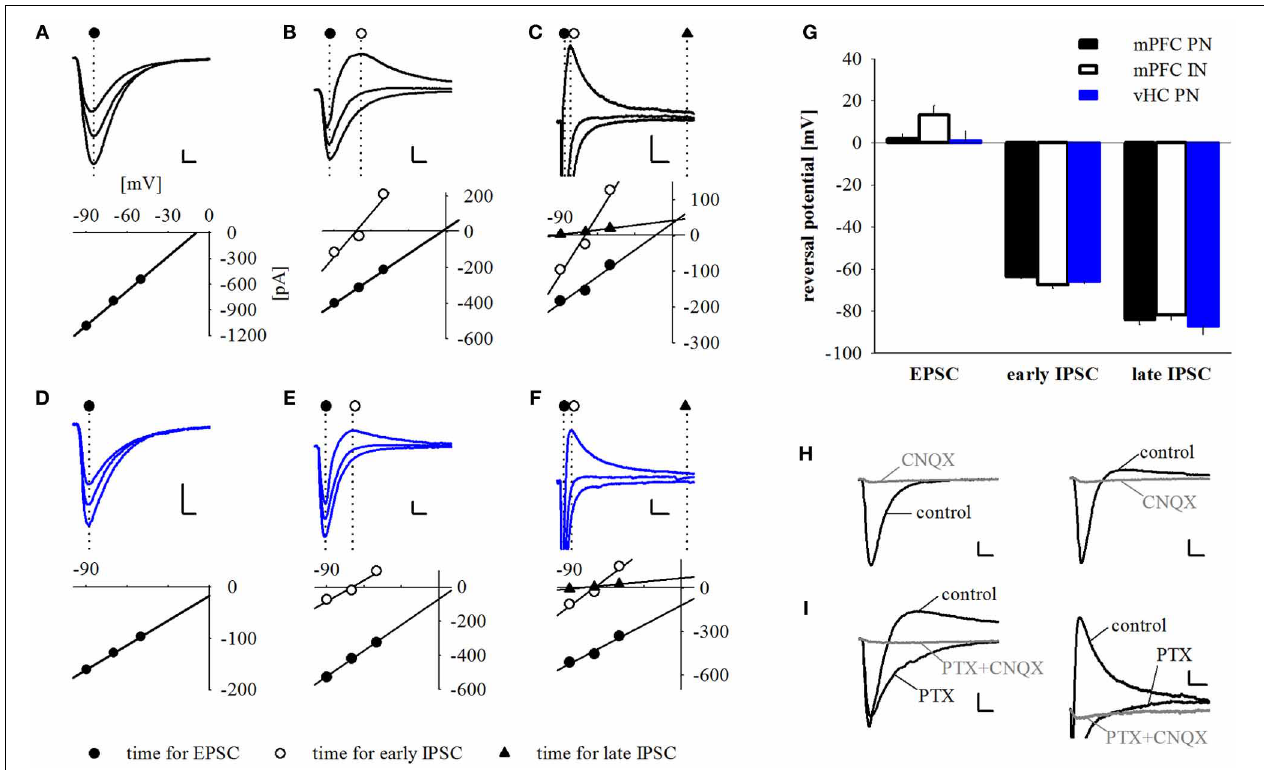
FIGURE 4 | Synaptic responses are comprised of early EPSCs and GABA A and GABA B mediated feed-forward IPSCs. (A–F) Example traces and corresponding current-voltage relationship plots for pure excitatory (A,D) , excitatory and early inhibitory (B,E) and excitatory plus early and late inhibitory (C,F) synaptic currents elicited by either mPFC ( A–C , black traces) or vHC ( D–F , blue traces) afferent fiber activation. Responses were recorded at holding potentials of − 90, − 70 and − 50mV. Dotted lines and symbols represent time of current measurement for excitatory, early, and late inhibitory components. Scale bars for (A,B,E) : 100pA/5ms; for (C,F) : 50pA/25ms; for (D) : 25pA/5ms. (G) Summary graph of reversal potentials for PNs with mPFC input (EPSC: 1.88 ± 2.67mV, n = 42; early IPSC: − 63 . 65 ± 0 . 94mV, n = 42; late IPSC: − 84 . 06 ± 2 . 56mV, n = 7), INs